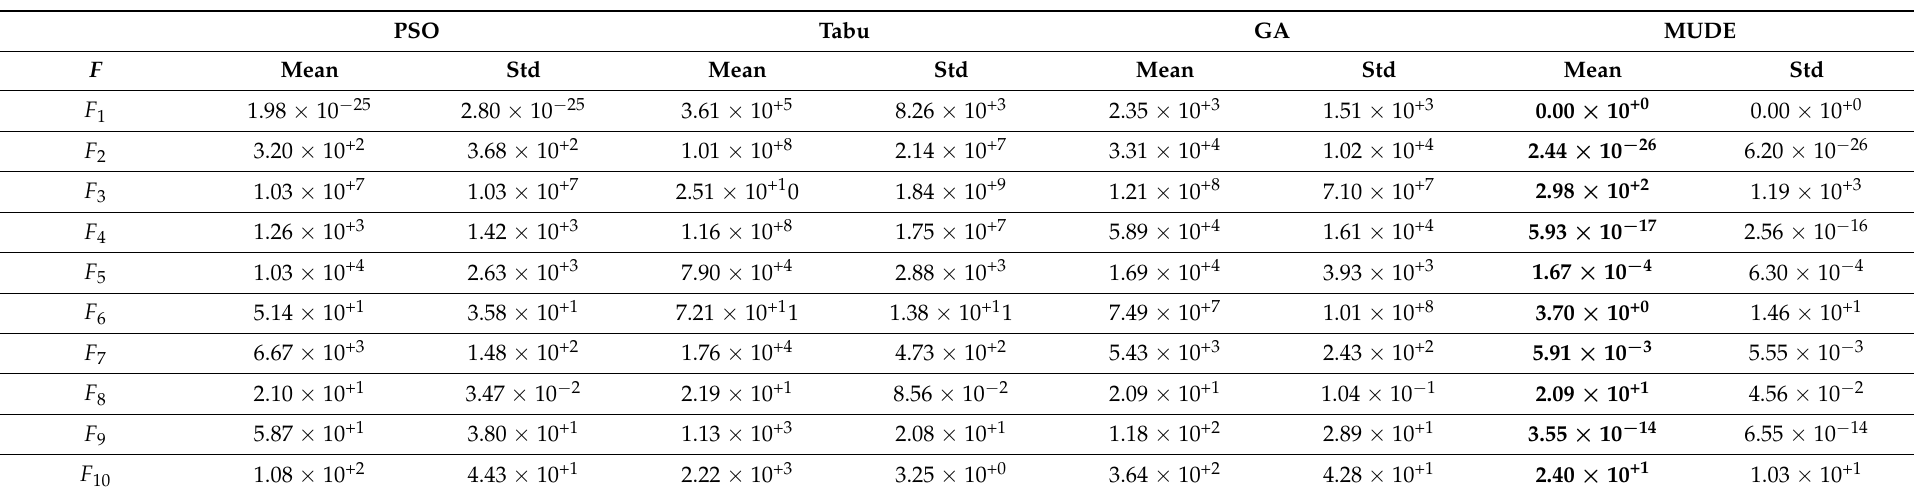
Table 6. Comparison with other algorithms for dimensions D =